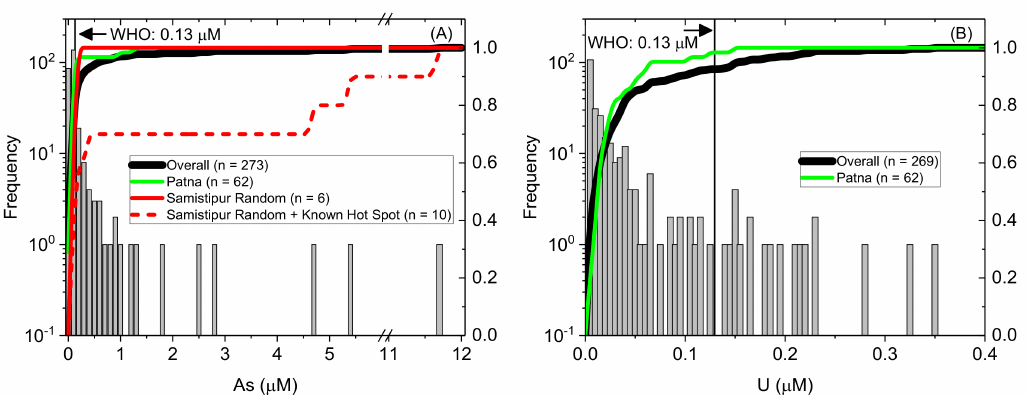
Figure 5. Histogram and cumulative frequency distribution curves for ( A ) As and ( B ) U in Bihar, India with WHO provisional guidelines [4] for As (0.13 µ M; 10 µ g.L − 1 ) and U (0.13 µ M; 30 µ g.L − 1 ) shown in solid lines. Histograms are shown for the overall dataset. The cumulative frequencies are included for the overall dataset (bold black line; n = 273 for As and n = 269 for U) and the Patna district subset (neon green line; n = 62). On (A) two lines for Samastipur are shown indicating one containing random sampling only ( n = 6) and another with the inclusion of both random and samples from a known As “hot spot” ( n =